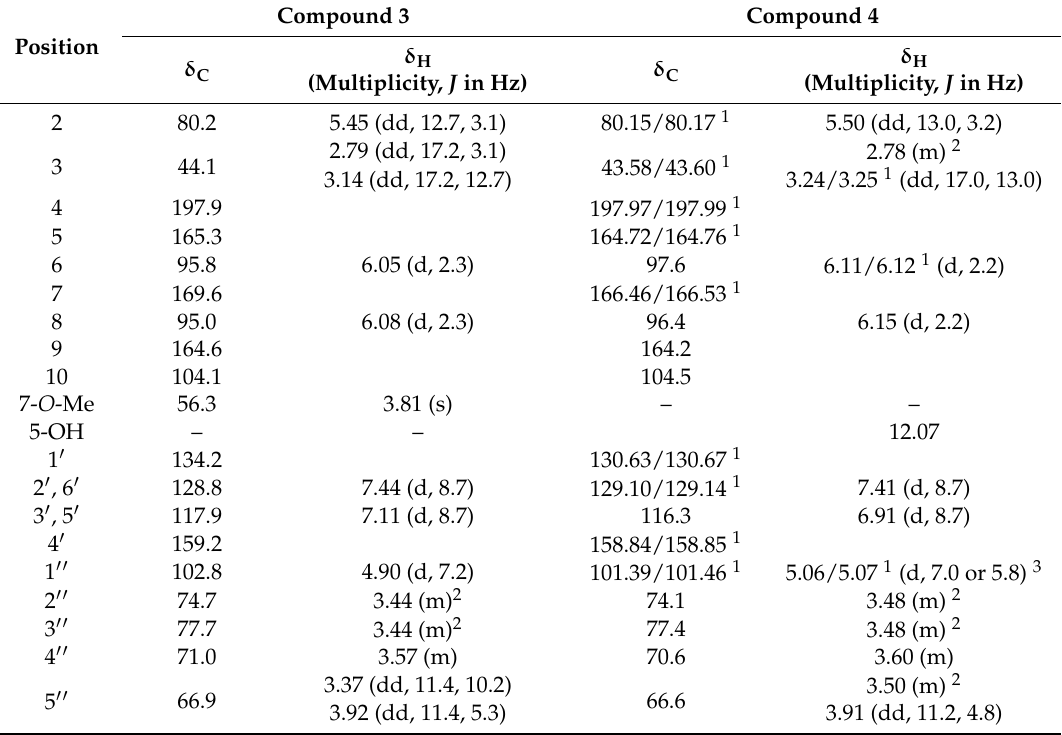
Table 1. 13 C and 1 H NMR data for compounds 3 (methanol- d 4 ) and 4 (acetone- d 6 ).